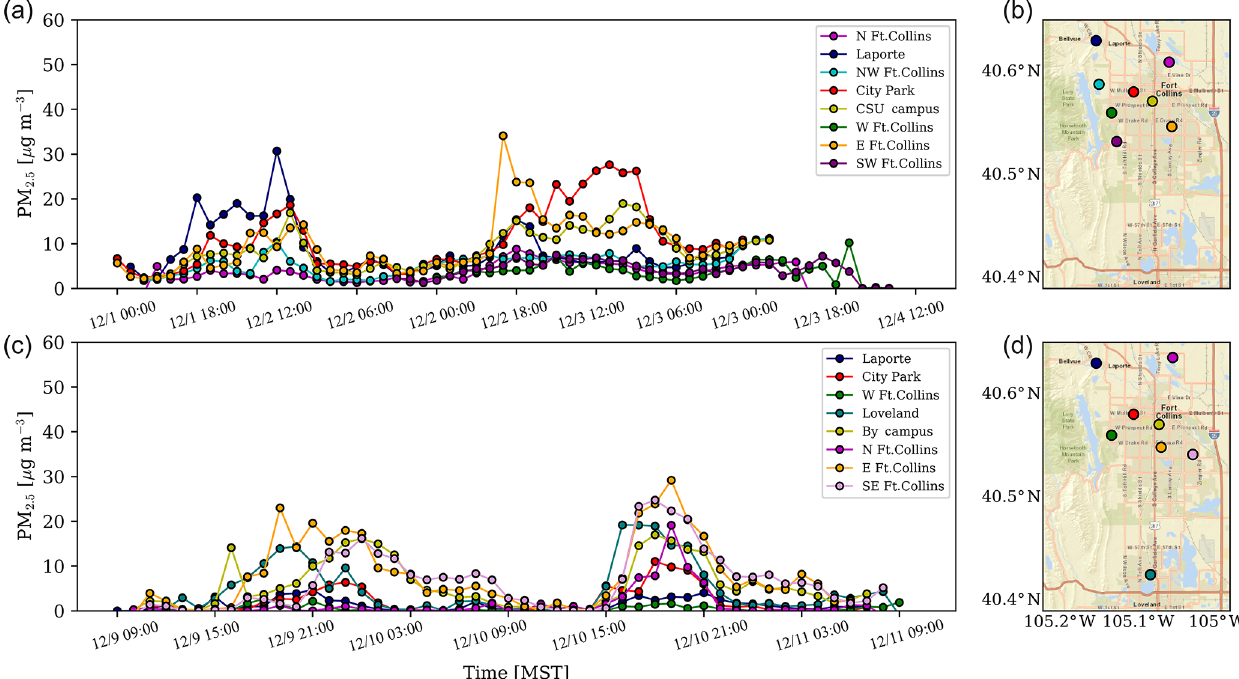
Figure 8. Time series of filter-corrected hourly averaged PM 2 . 5 concentrations from the Plantower PMS5003 sensor inside the AMOD for 1–3 December (a, b) and 9–11 December (c, d) sampling periods. Maps show sampling locations for each sampling period (uncorrected